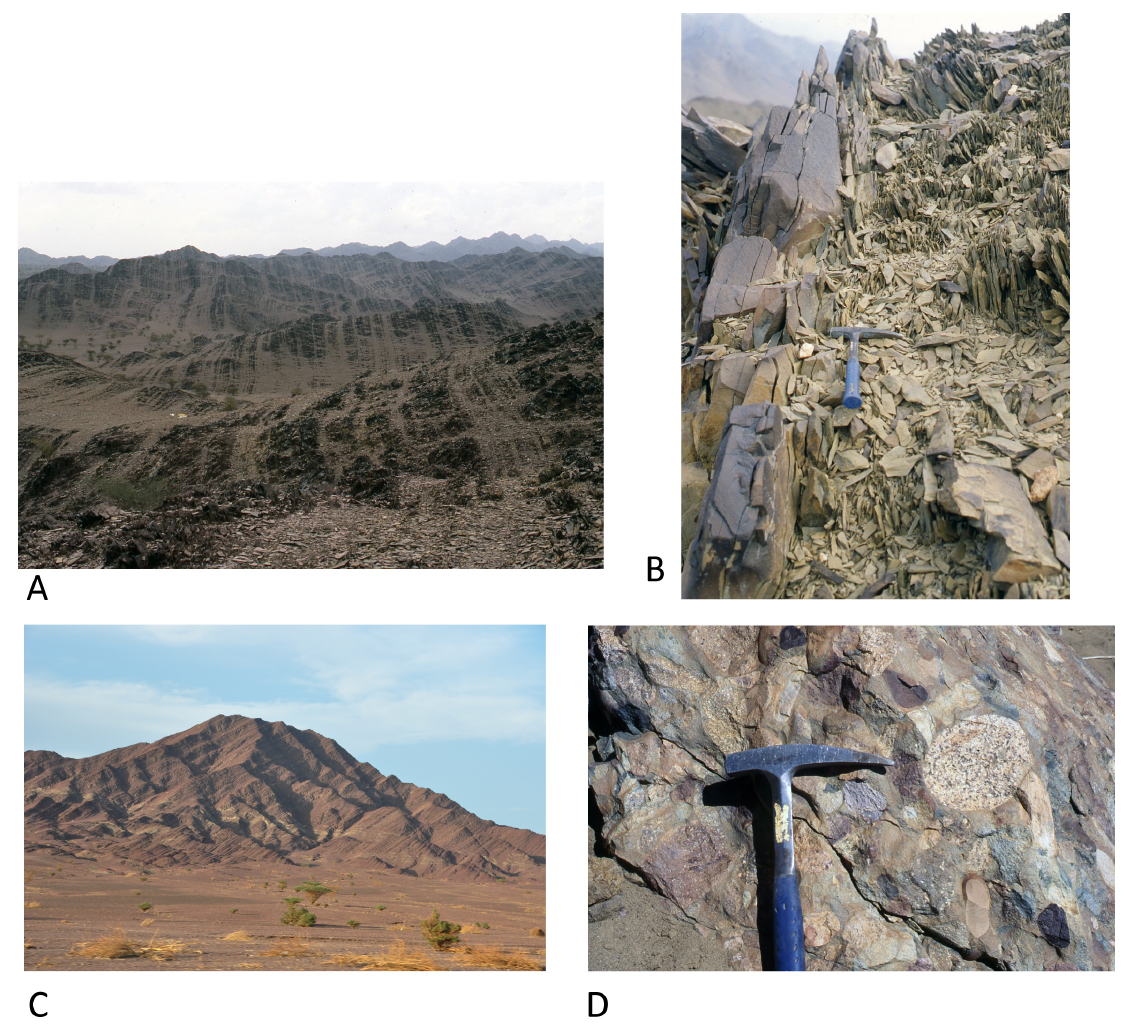
Figure 8. Features of the Hadiyah group, As Sard basin. ( A ) General view of steeply dipping well-bedded Tura’ah formation sandstone and siltstone; ( B ) Close up of fine-grained sandstone (to left) and siltstone (to right) showing prominent bedding-parallel cleavage in the siltstone; ( C ) Well-bedded sandstone and siltstone in the Qaraqah member of the Tura’ah formation, showing its characteristic purple-red color; ( D ) Aghrad formation clast-supported polymict pebble-cobble conglomerate with well-rounded clasts, which in this exposure include abundant granite and lesser amounts of feldspar porphyry, purple chert, siltstone, and dark green